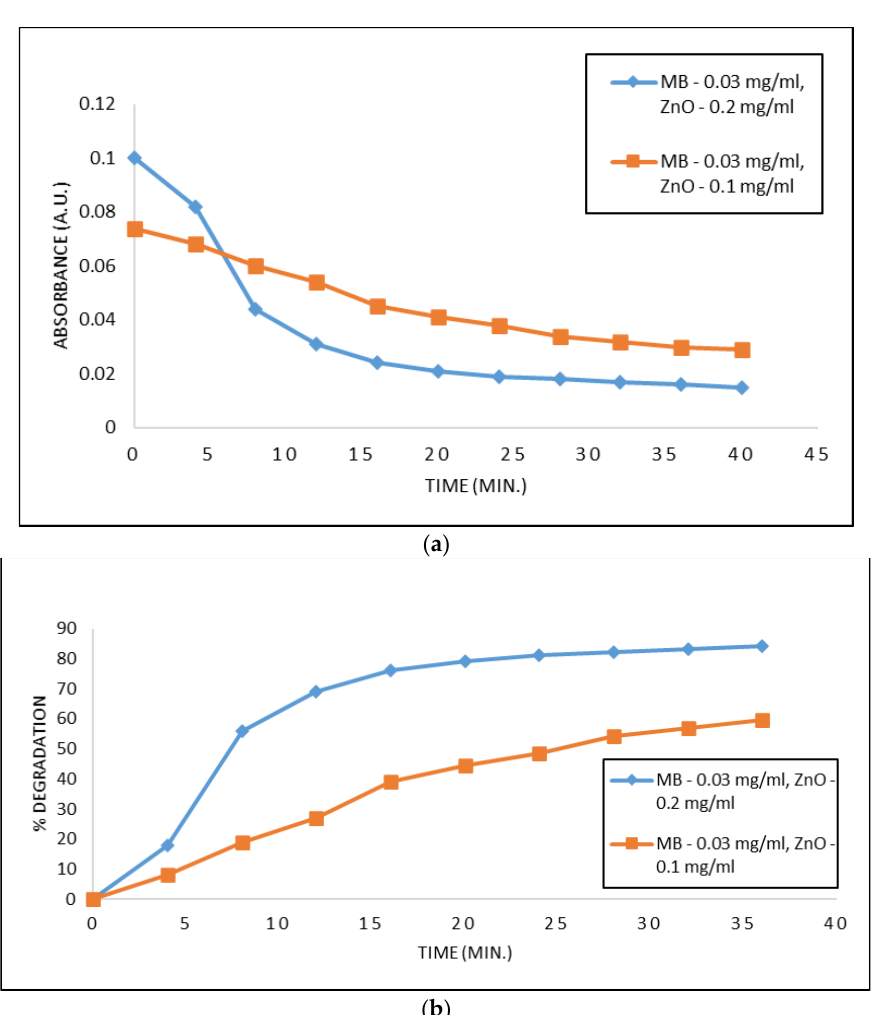
Figure 7. Graph showing the photocatalytic degradation of the model pollutant MB at 0.03 mg/mL with varying ZnO nanoparticle concentration ( a ) Absorption ( b ) %degradation. Rate constant has been calculated for all the four cases (A to D) using Langmuir Hin- shelwood equation. The rate constant ideally should follow the first order reaction which is linear as shown in Figure 8. The slope, intercept and the R 2 values are shown in Table 2. Figure shows the kinetics of MB at two different concentrations (0.06 mg/mL and 0.03 mg/mL) with ZnO nanoparticles added reaction at two different concentrations 0.2 mg/mL and 0.1 mg/mL. The slope of the equation directly gives the rate constant. The rate constant for cases A, B, C and D are 3.16 × 10 −4 /s, 1.75 × 10 −4 /s, 2.19 × 10 −4 /s and 1.13 × 10 −4 /s respectively. These values of the rate constant are in accordance with the previously re- ported work [81]. When compared to case D, the rate constant of A is three times as re- ported in a similar study earlier [82].